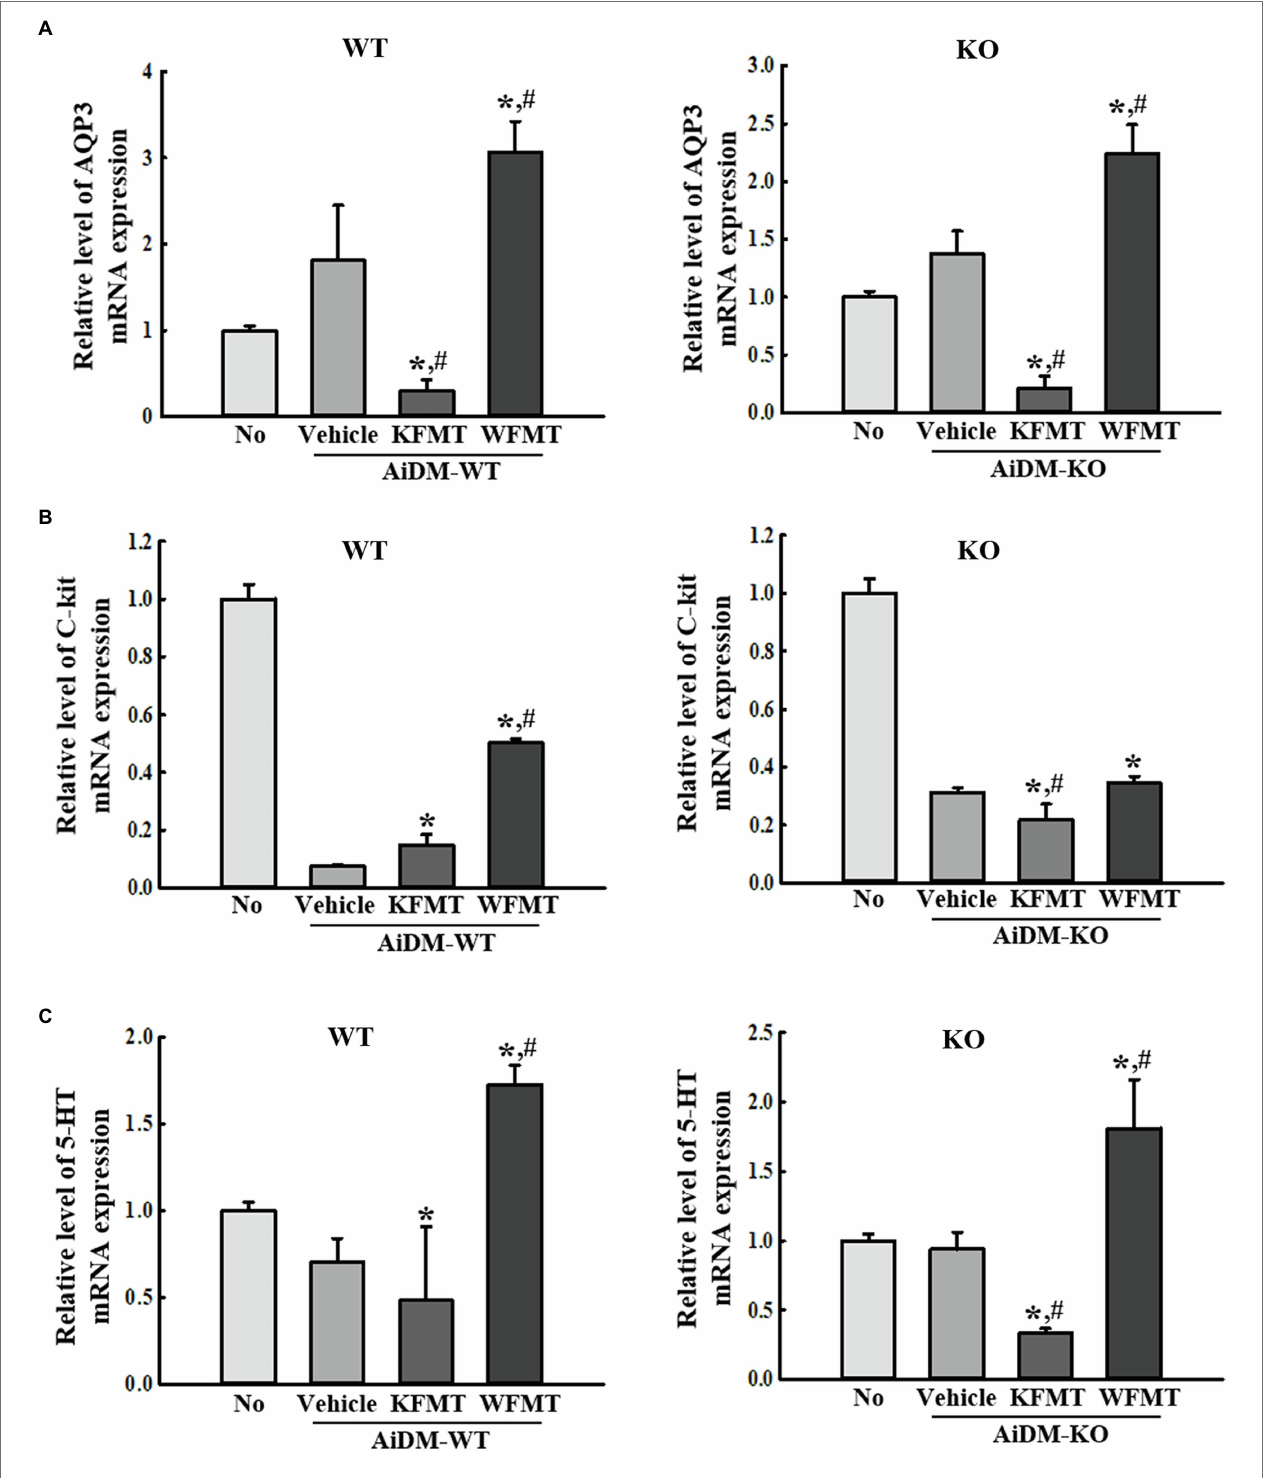
FIGURE 7 | Molecular regulator expressions in FMT mice. (B) RT-qPCR analyses of AQP3 (A) , C-kit (B) , and 5-HT (C) . The levels of AQP3, C-kit, and 5-HT transcripts in the total mRNA of mid-colons were measured by performing RT-qPCR with specific primers. The mRNA levels of the three genes were based on the intensity of actin as an endogenous control. Three to five mice per group were used to prepare total RNA, and RT-qPCR analyses were performed in duplicate for each sample. The data are reported as mean ± SD values. * p < 0.05 compared with the No-treated group. # p < 0.05 compared with the AiDM+Vehicle-treated group. WT, wild type; KO, knockout; FMT, fecal microbiota transplantation; KFMT, knockout mice FMT; WFMT, wild-type mice FMT; AiDM, antibiotics-induced depletion of microbiota; AiDM-WT, AiDM-wild-type mice; and AiDM-KO, AiDM-knockout